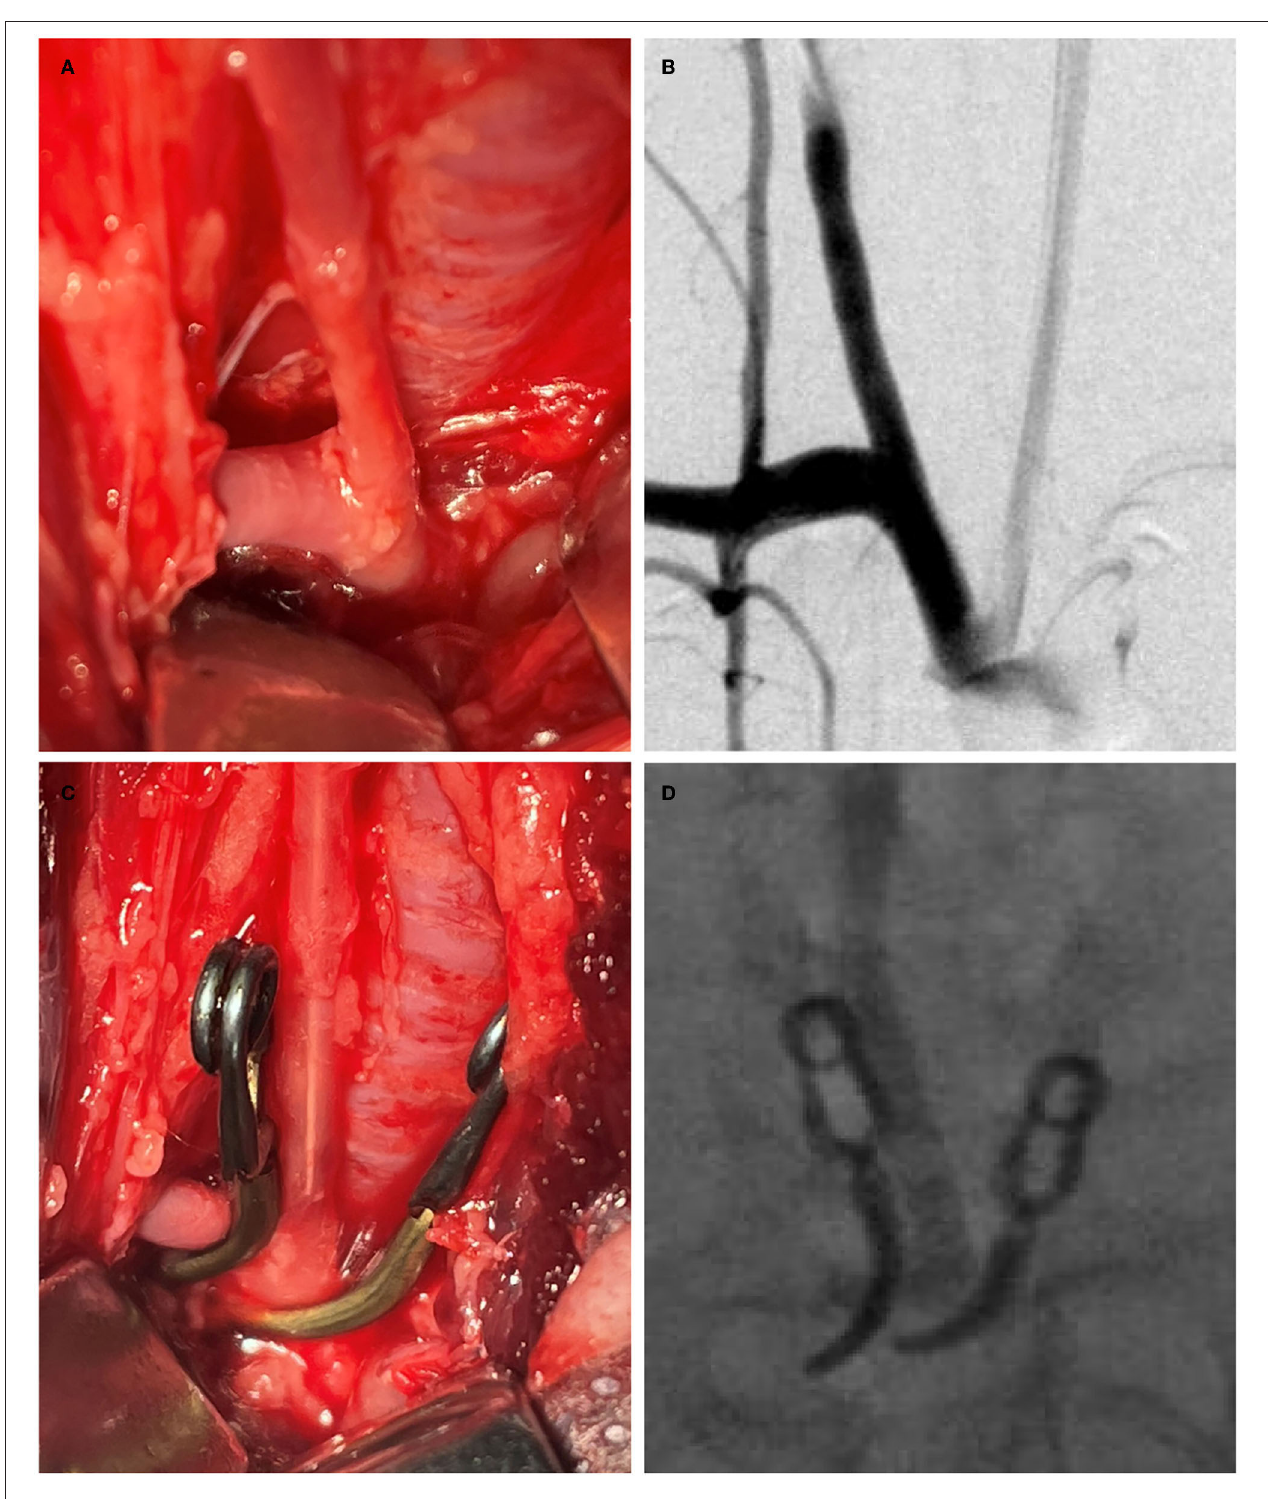
FIGURE 2 | The process of the improved surgical technique with two temporary clips. (A) The origin of the right common carotid artery (RCCA) at its junction with the subclavian and brachiocephalic arteries was exposed; (B) Angiography shows the subclavian artery, the brachiocephalic artery, and the RCCA via a 20-gauge intravenous catheter; (C) Two temporary aneurysm clips were placed closely medially and laterally, respectively to the origin of RCCA which was inserted by a 20-gauge intravenous catheter; and (D) Under fluoroscopy, the origin of RCCA was confirmed that it can be filled with elastase mixed with a contrast agent without